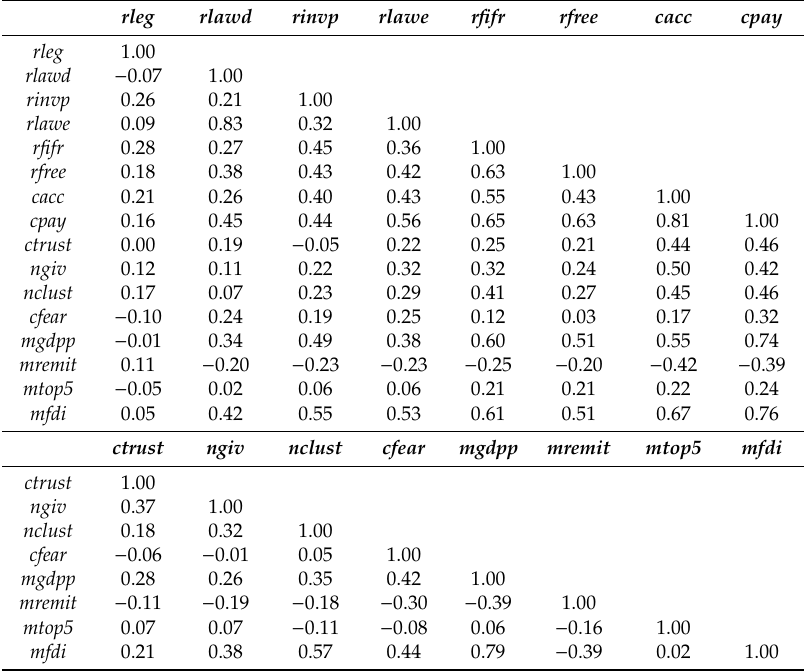
Table A1. Pairwise Correlations between Explanatory